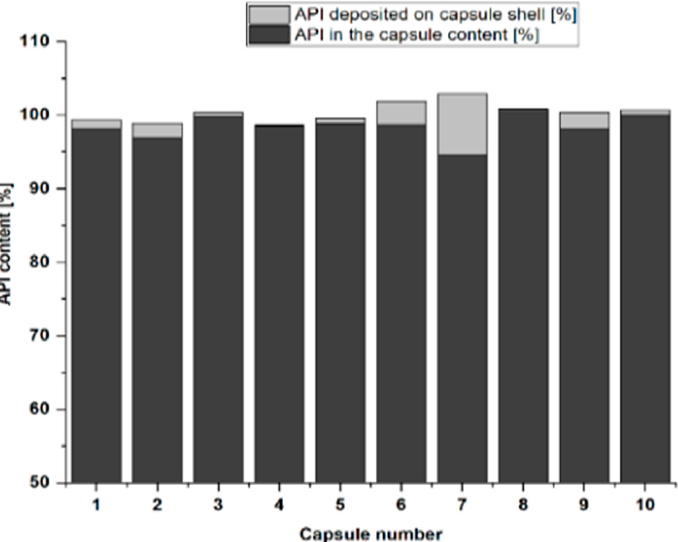
Figure 5. Total API content (%) in the capsules of 1 mg enalapril maleate with Syloid 244 FP, differentiated in the API deposited on the capsule shell and API in the capsule content ( n = 10, dosing device: Hamilton syringe).